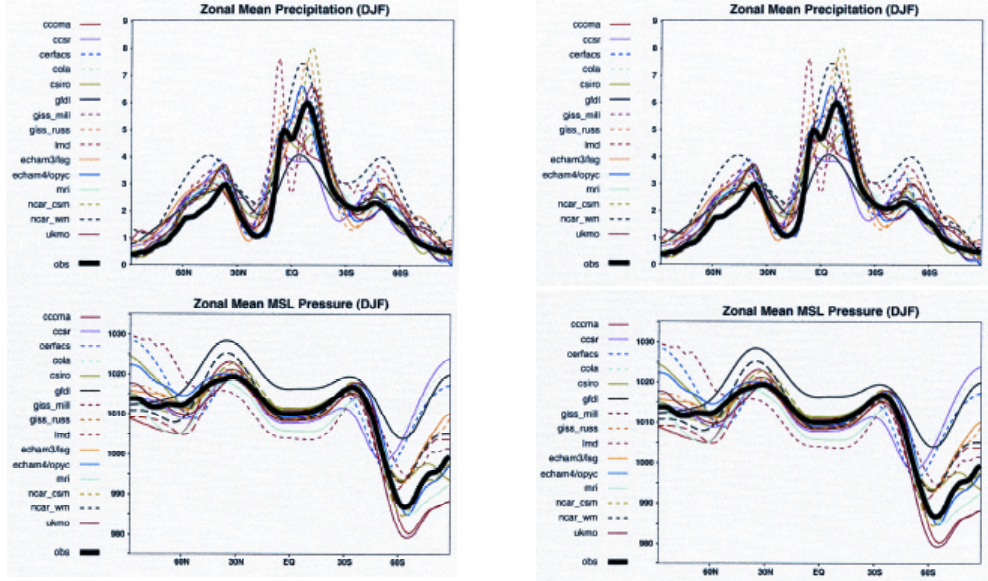
FIGURE 15. As in Fig. 14, but precipitation in mm per day (top) and mean sea level pressure in hPa (bottom). Averages over all models are shown at left and zonal mean values for individual models at right. (From Lambert and Boer